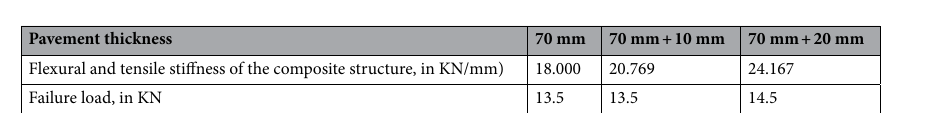
Table 6. Flexural and tensile stiffness and failure load of the composite structure formed by different thicknesses of double-layer pavement under the action of a negative bending moment.